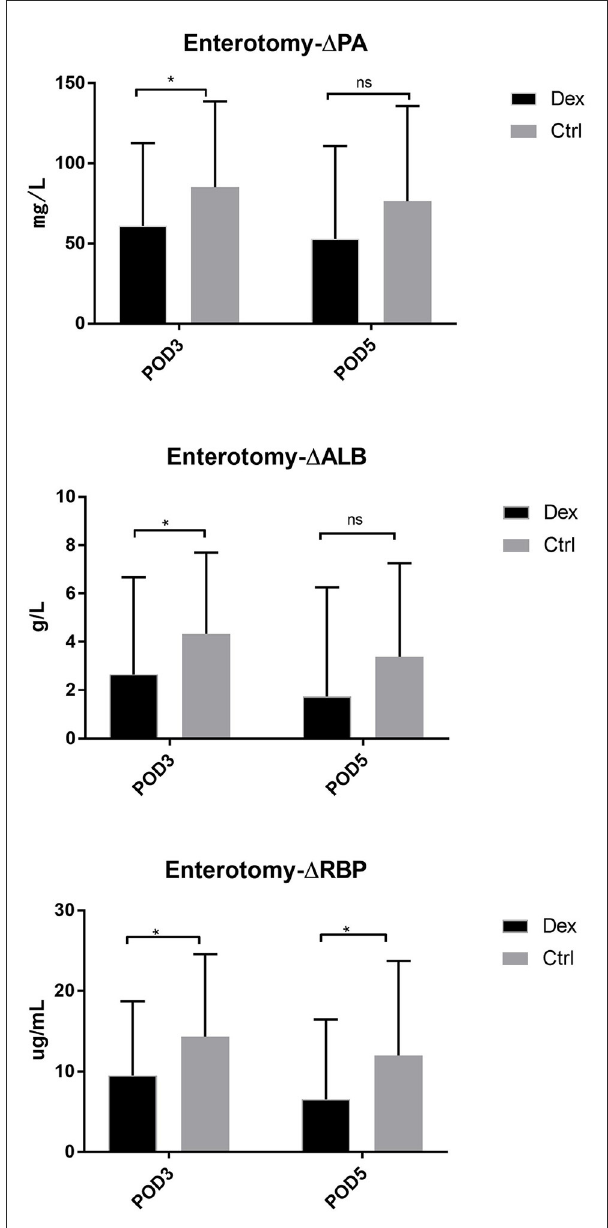
FIGURE5 The decrease of PA, ALB, RBP in POD3 and POD5 in enterotomy surgery group. 1 represents the difference between preoperative value and postoperative value. ns P > 0.05, * P <